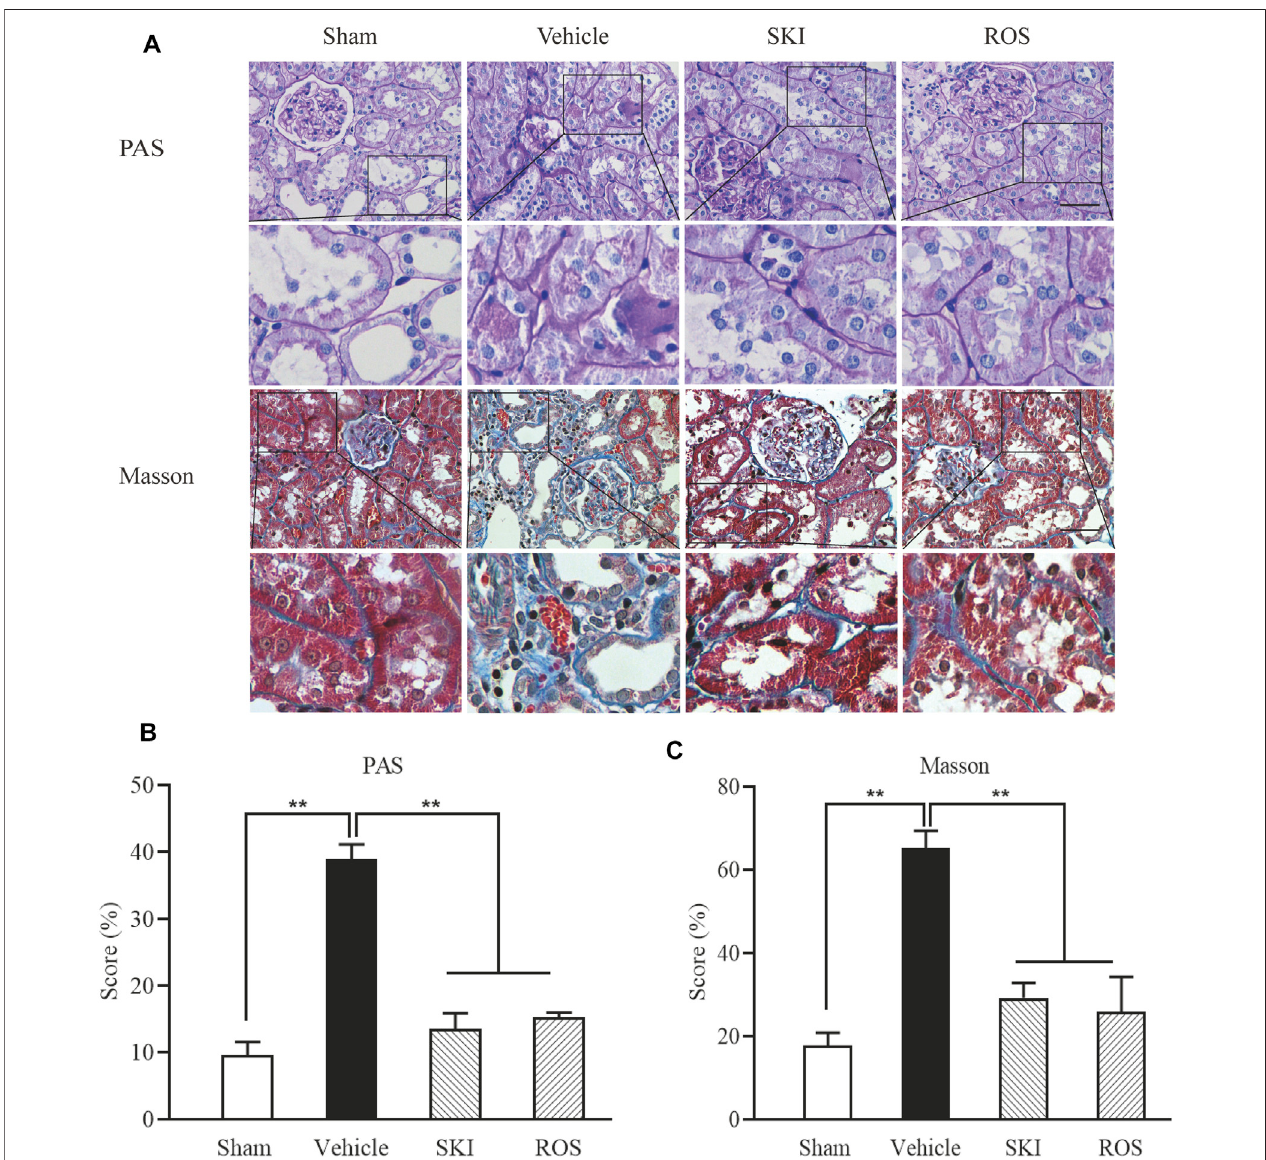
FIGURE 3 | The effects of SKI and ROS on tubulointerstitial pathological changes in vivo . (A) PAS and Masson staining in the kidney ( × 200); (B) The rate of ECM/ interstitial area; (C) The rate of collagen/interstitial area. Scale bar (cid:2) 100 μ m. Data are expressed as mean ± S.E. ** p < 0.01. Abbreviations: PAS, Periodic acid-Schiff; ECM, extracellular matrix; ROS, rosiglitazone; SKI, Shenkang injection.